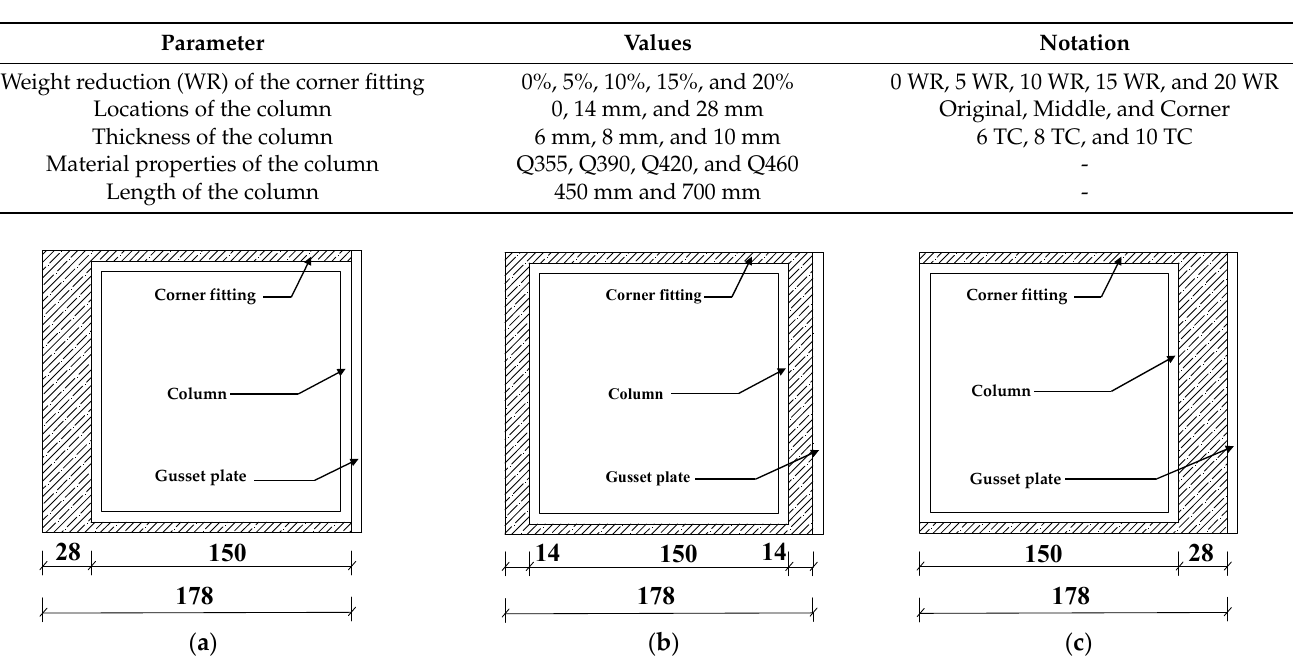
Table 3. Values of the parameters.